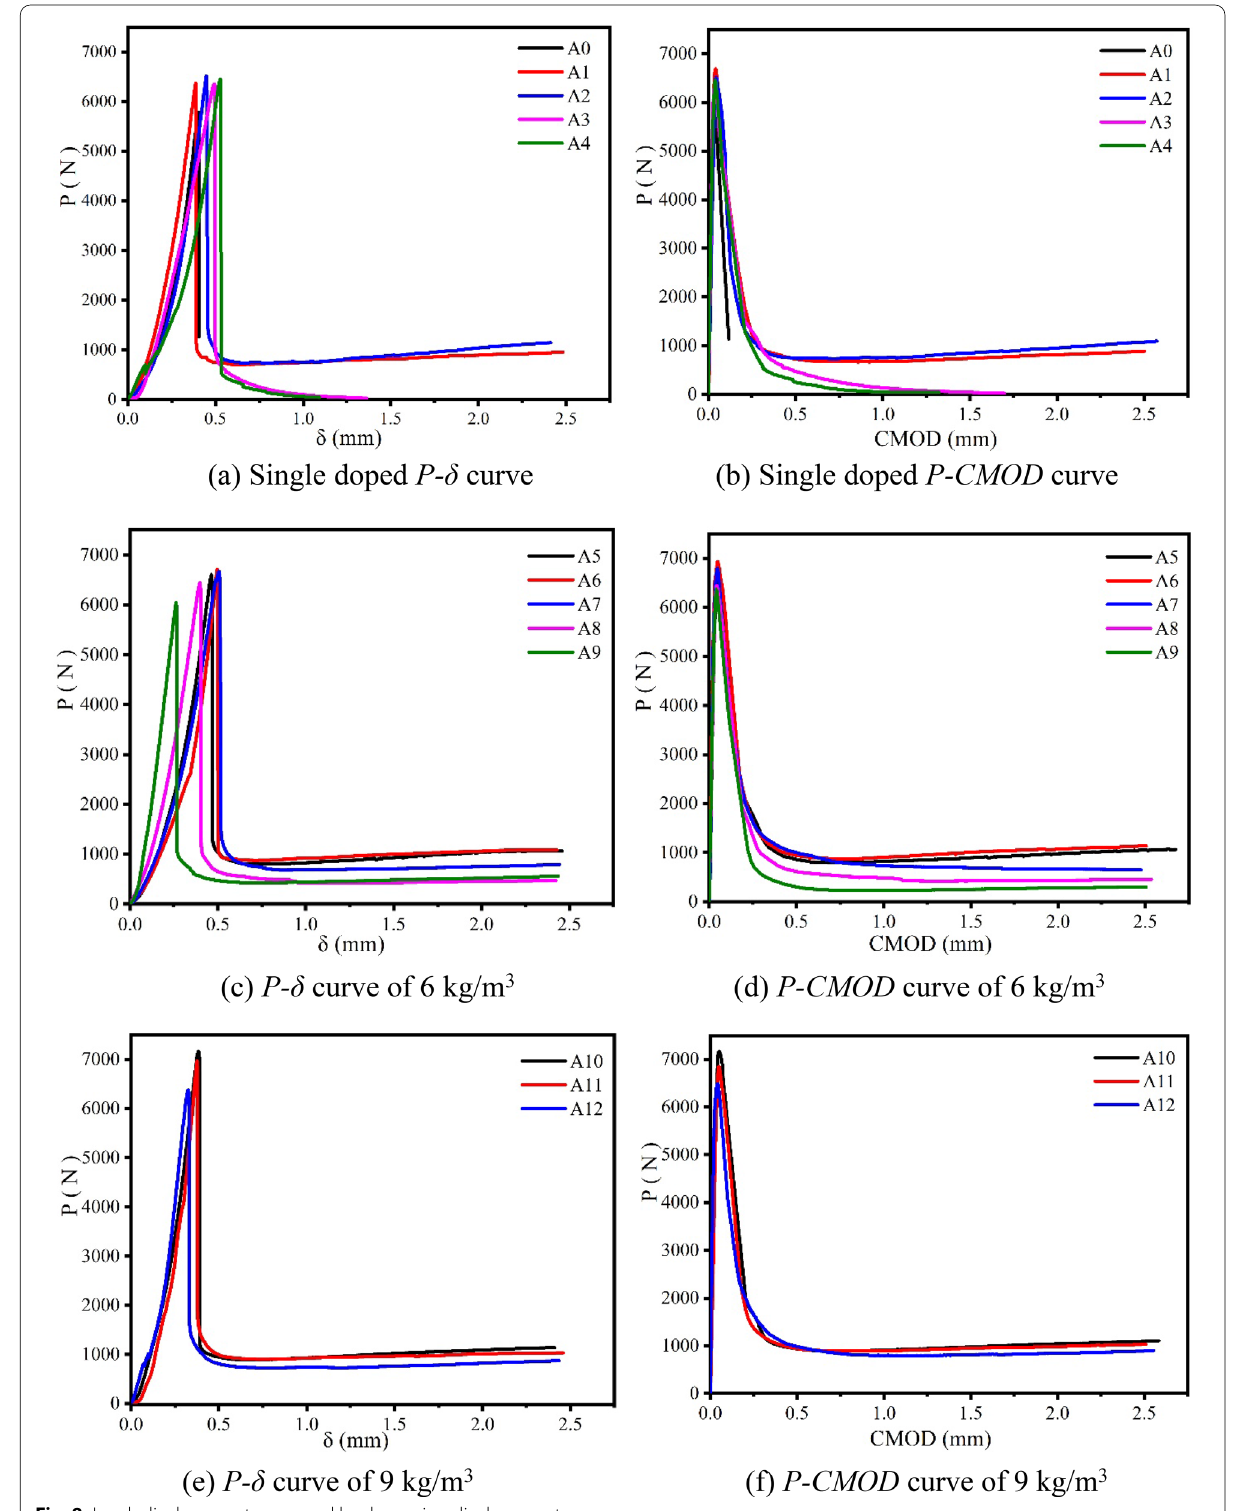
Fig. 8 Load–displacement curve and load-opening displacement